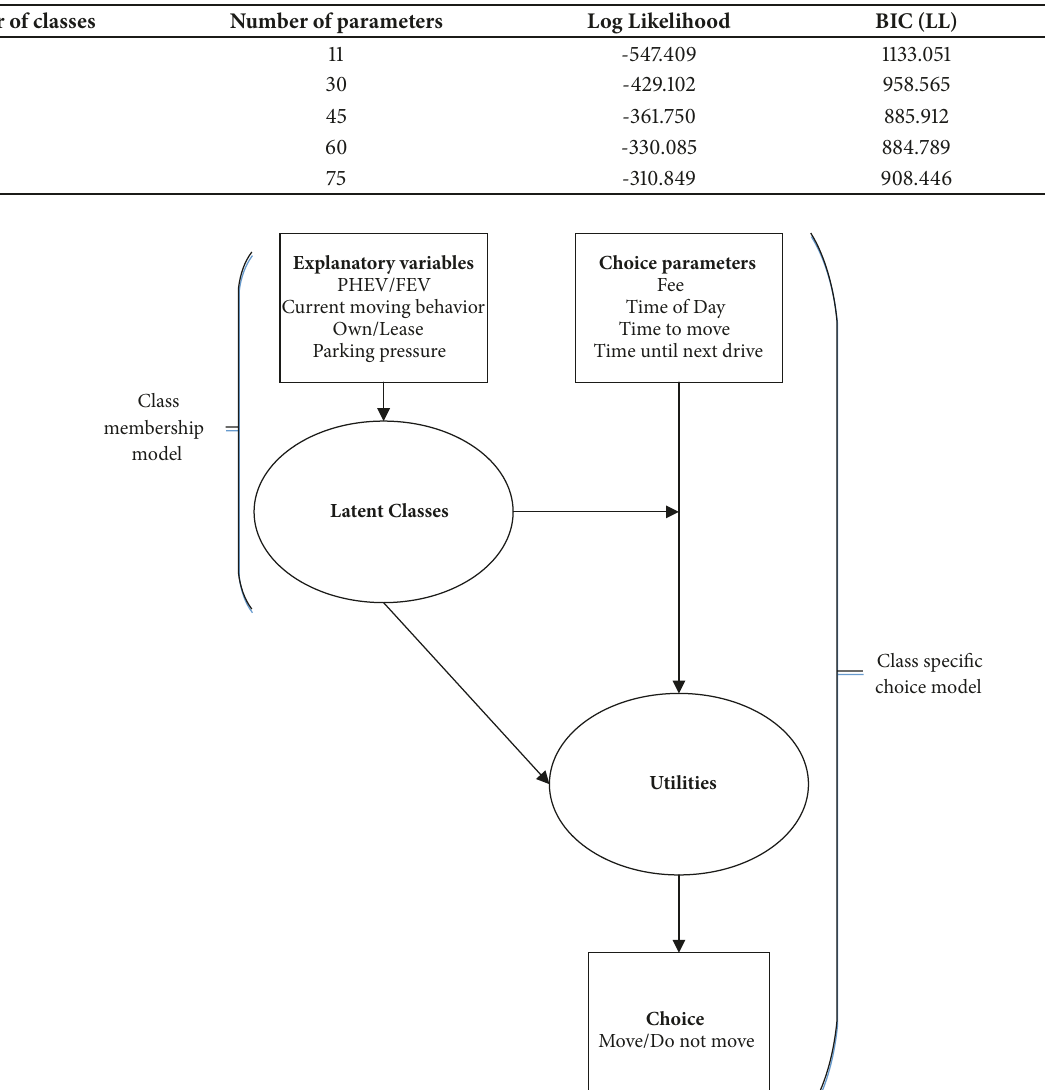
Table 5: Model fit estimators for different number of latent classes.